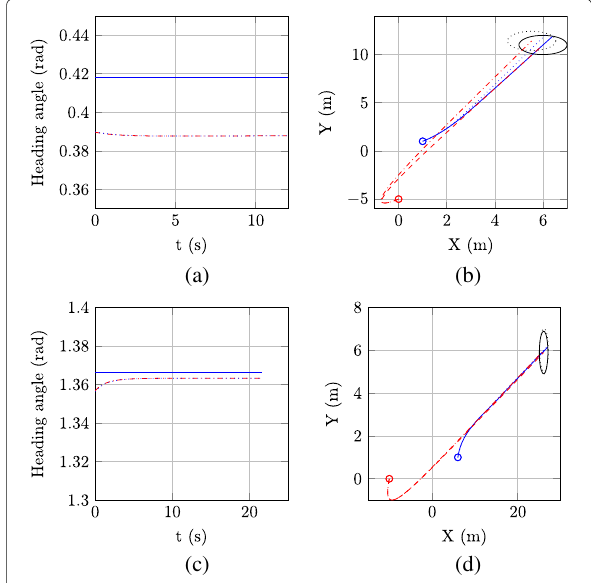
Table 2 Results obtained using optimization approach, with and without ˆ (cid:12) v approximation, for capacity game Fig. 2 Comparison of controls and trajectories obtained for games Grid points where Percent with running cost L = 1 and L = A + Br . The initial grid conditions solution was found Optimization 10 3 iterations 5 6.2 approach